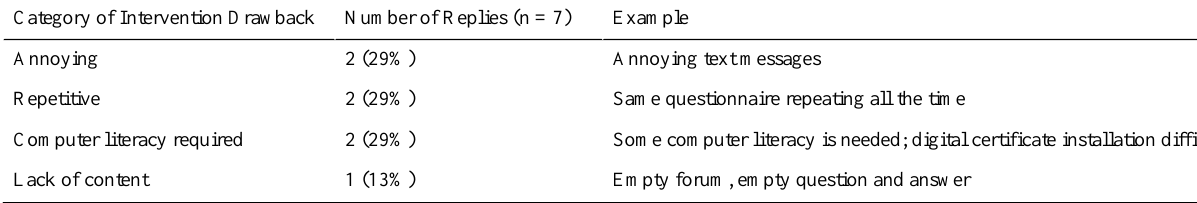
Table 7. Negative feedback provided by patients in the intervention group: categories and examples ExampleNumber of Replies (n = 7)Category of Intervention